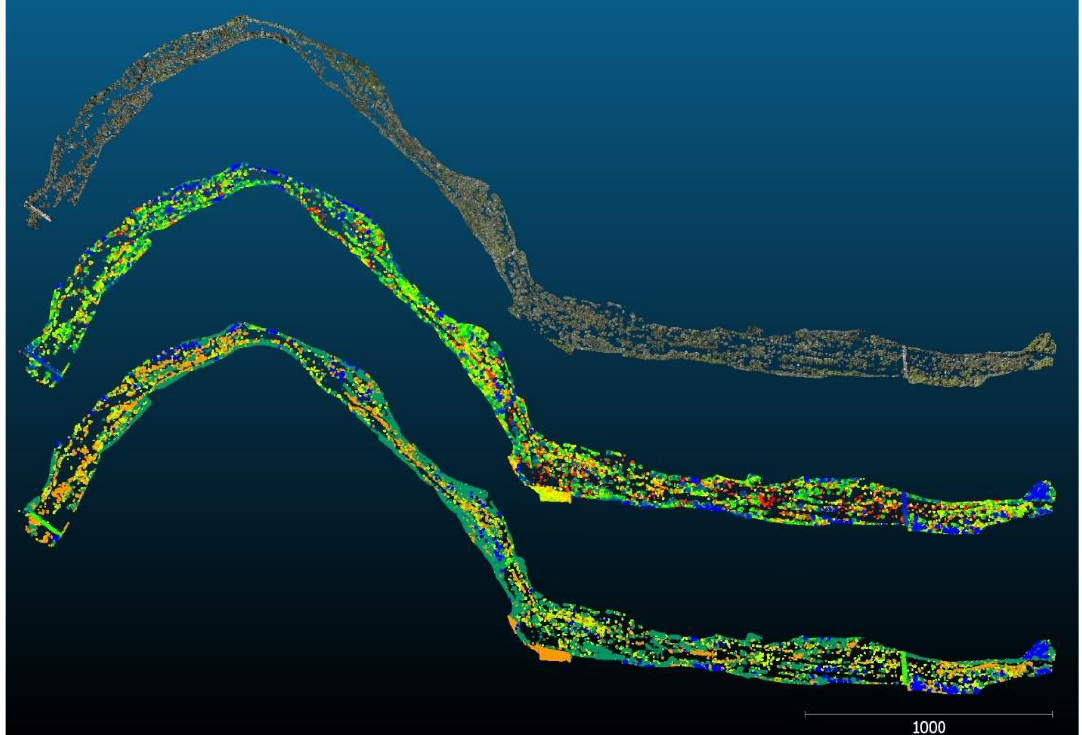
Figure 6. Top: RGB point cloud after normalization. Middle: segmented point cloud. Bottom: classified point cloud with the classes giant reed (aquamarine), Aleppo pine (blue), French tamarisk (orange), Ground (green), Aleppo pine (blue), and other